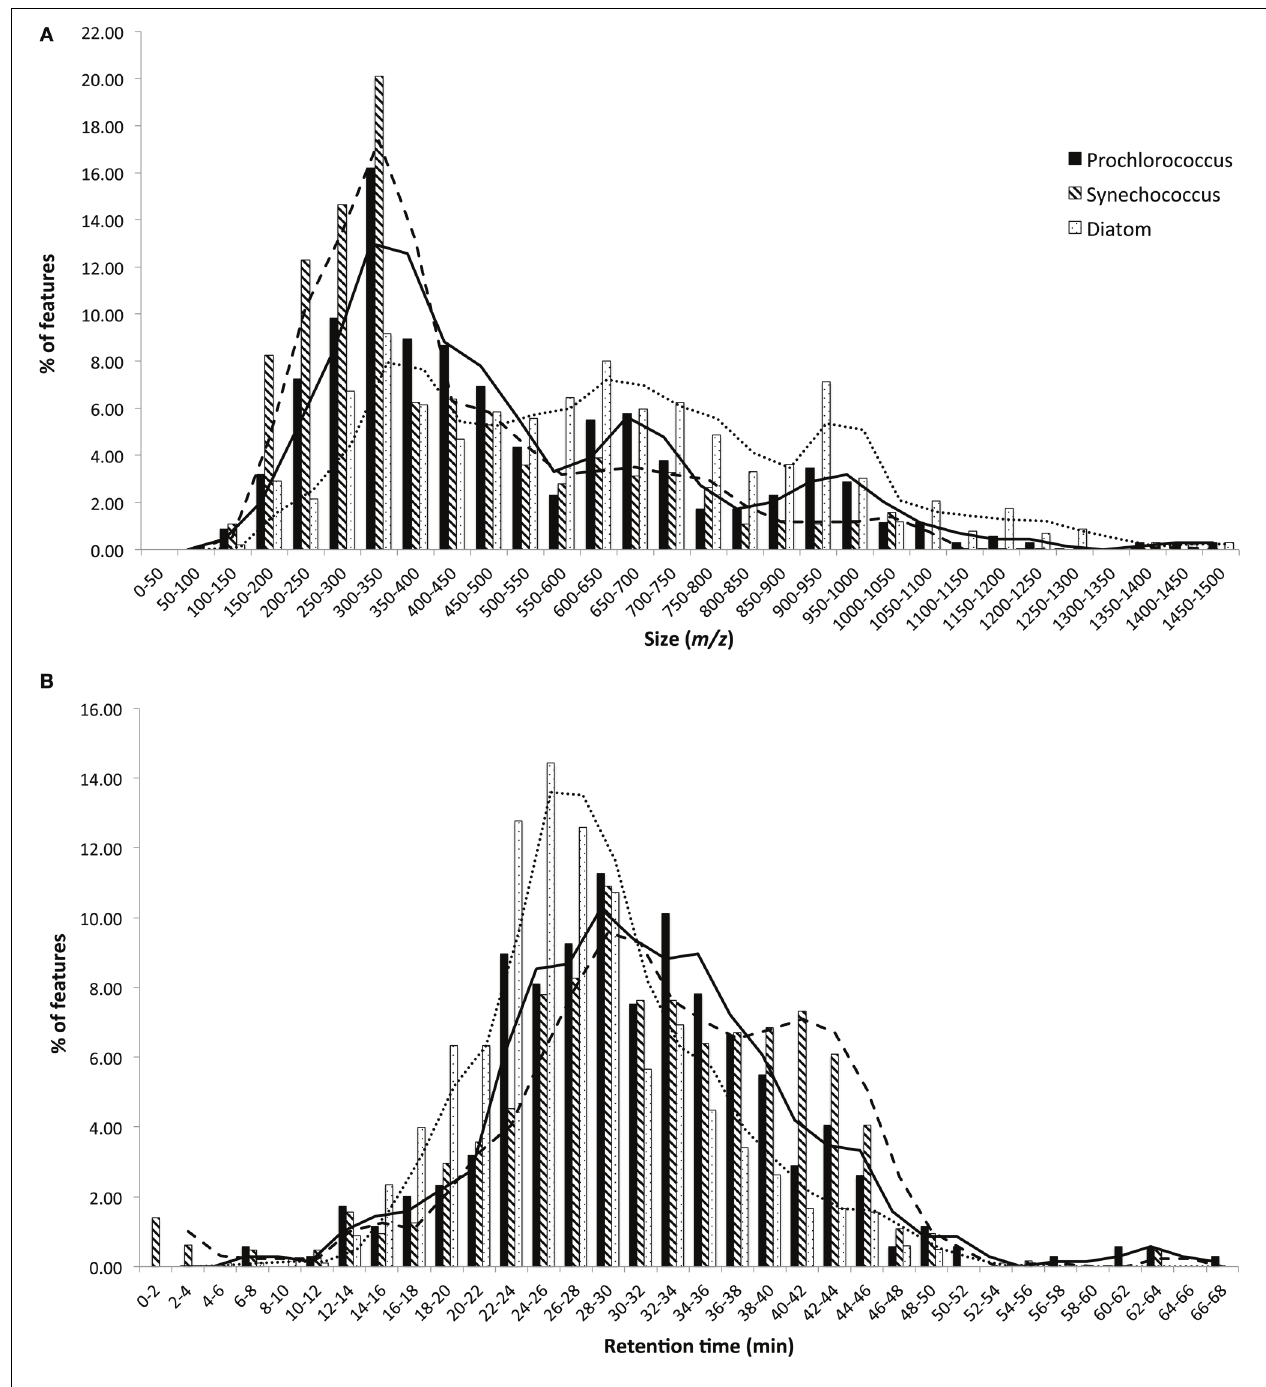
FIGURE 2 | Histograms comparing the size (A) and polarity (B) distributions of DOM P derived from representative strains from each major phytoplankton group. Bars indicate the percentage of features that fall within each bin labeled on the X-axes and